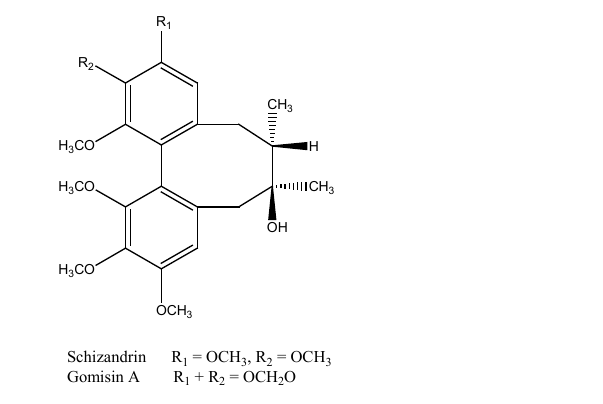
Figure 2. HPLC chromatogram of a 95 % ethanol extract of S. chinensis . The analysis conditions were: column, Cosmosil 5C18-AR-II 4.6 × 250 mm (Nacalai Tesque); flow rate, 1 mL/min; detector, 254 nm; solvent system, 0–30 min, 5% MeOH to 100% MeOH; 30–50 min, 100% MeOH. Peak identifications: Sch, schizandrin; Gom A, gomisin